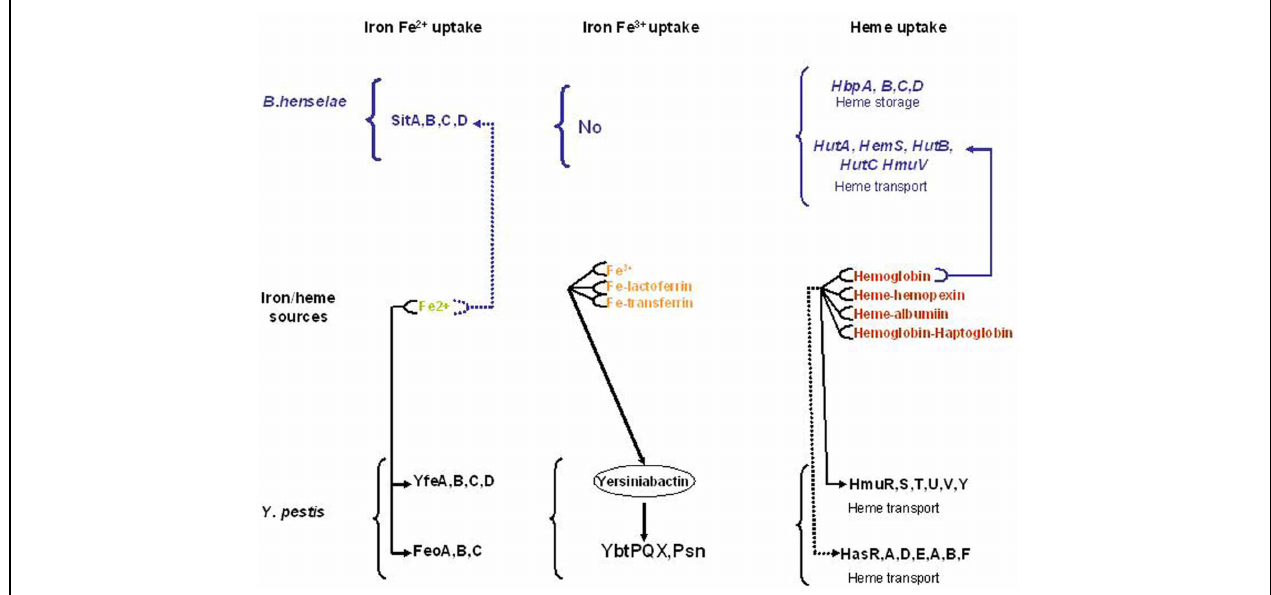
FIGURE 2 | Characterized (—) and predicted (—) Iron and heme uptake systems in Bartonella henselae and Yersinia pestis